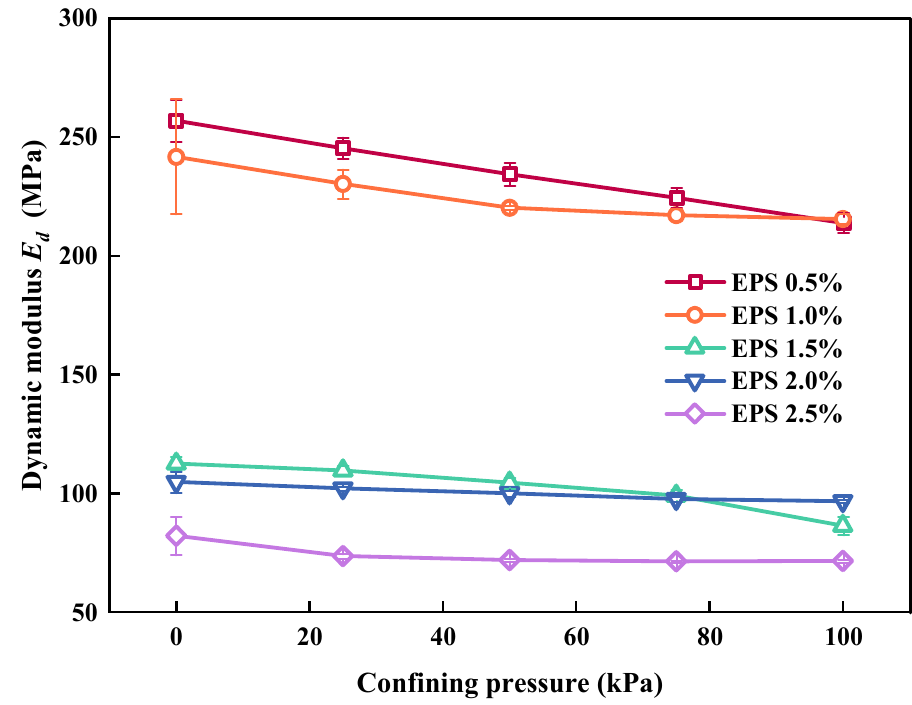
Figure 10. Relationship between con fi ning pressure and E d .